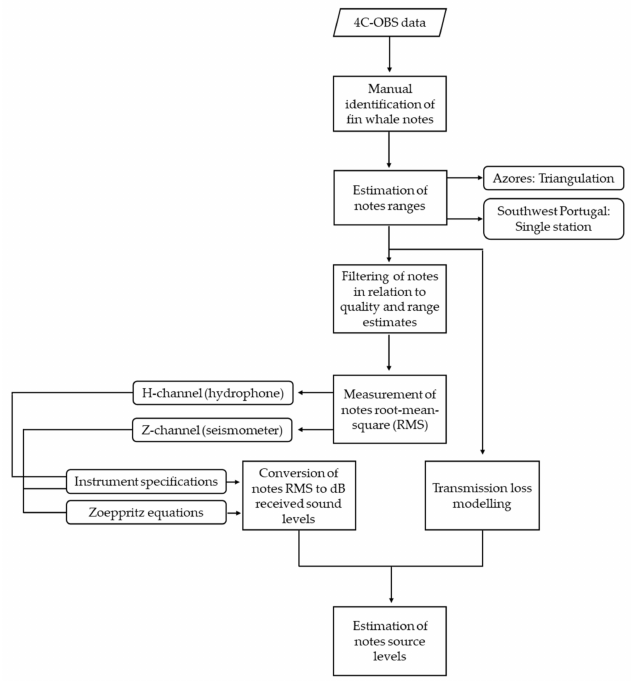
Figure 2. Flowchart of data acquisition and processing stages to estimate source levels of 20 Hz fin whale